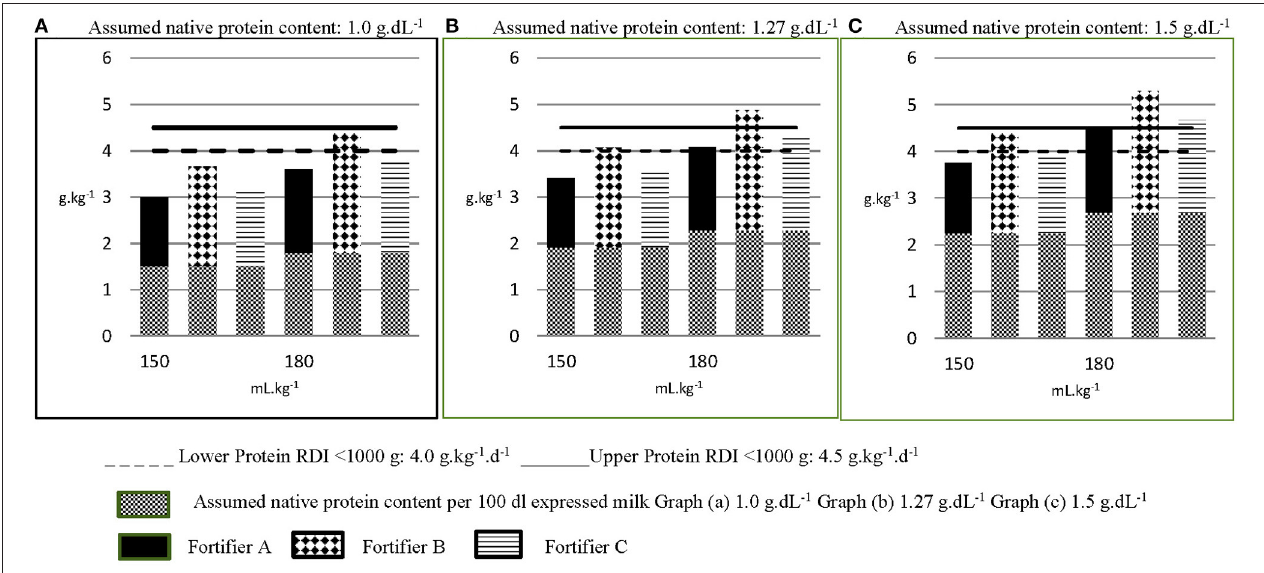
FIGURE 4 | Calculated estimated protein intakes from different fortified milk feeds. The native protein content per 100mL of milk feeds in Graphs A–C are 1.0g, 1.27g and 1.5g, respectively, representing the lowest, most common and highest assigned values in use across A&NZ, as reported in the survey. Each graph (A–C) depicts three different fortified milk feeds fed at 150mL.kg − 1 .d − 1 and 180mL.kg − 1 .d − 1 . The protein content of each milk feed is increased from its assumed native content, according to the protein content of the fortifier added (per 100mL expressed milk: Fortifier A: 1.0g protein; Fortifier B: 1.44g; Fortifier C: 1.1g). Graph (A) in Figure, representing fortified breast milk feeds assigned with an assumed native protein content of 1g.dL − 1 suggests that the recommended daily intake (RDI) for protein can only be met when the milk feed is fortified with Fortifier B and fed at 180mL.kg − 1 .d − 1 . Yet graph (B) , representing fortified breast milk feeds assigned an assumed native protein content of 1.27g.dL − 1 , suggests the lower RDI for protein can be met when the milk feed is fortified with Fortifier B and fed at 150mL.kg − 1 .d − 1 and that protein requirement is exceeded when this feed is fed at 180mL.kg − 1 .d − 1 . Graph (C) suggests that breast milk assigned an assumed native protein content of 1.5g.dL − 1 exceeds protein requirement when fortified with either fortifier B or fortifier C and fed at targeted volumes of 180mL.kg − 1 .d − 1